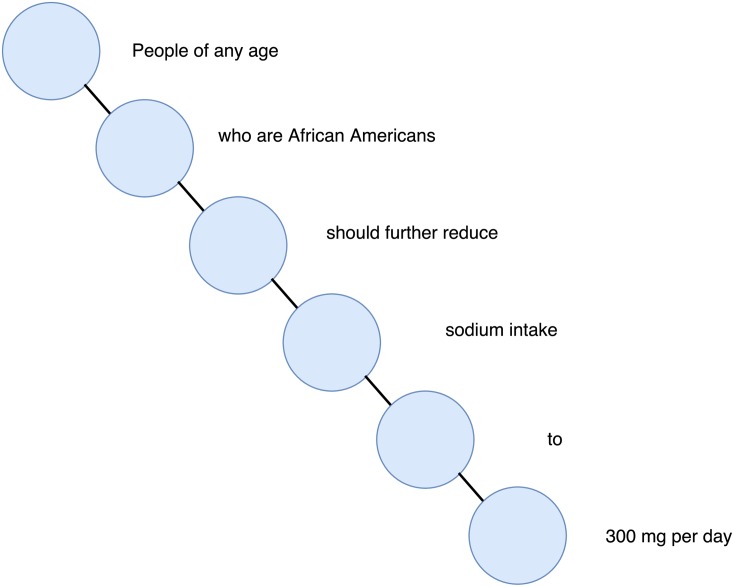
Graphic representation of the recommendation Φ1.